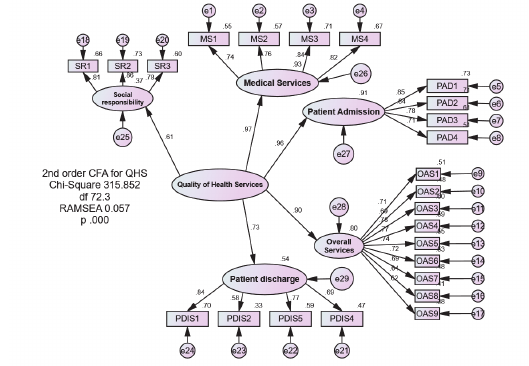
Fig. 3. Full Structure Equation Modeling (QHS dimensions – Pt.